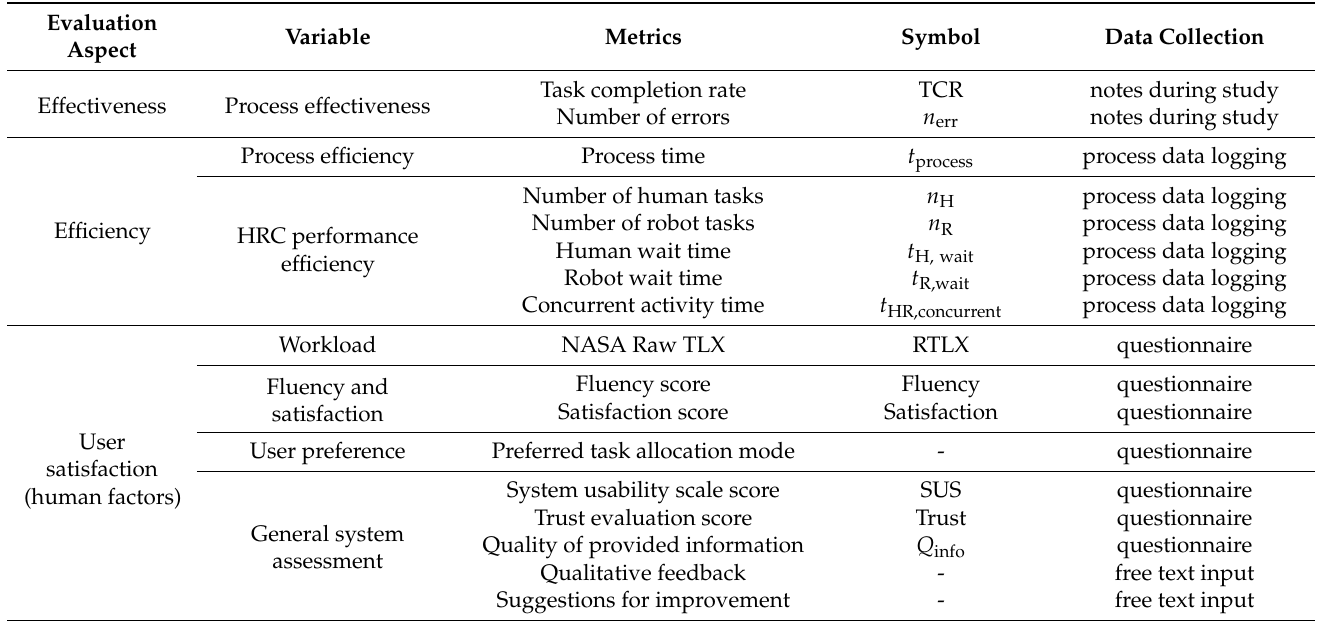
Table 2. Overview of investigated variables, utilized metrics, and the approach for data collection.